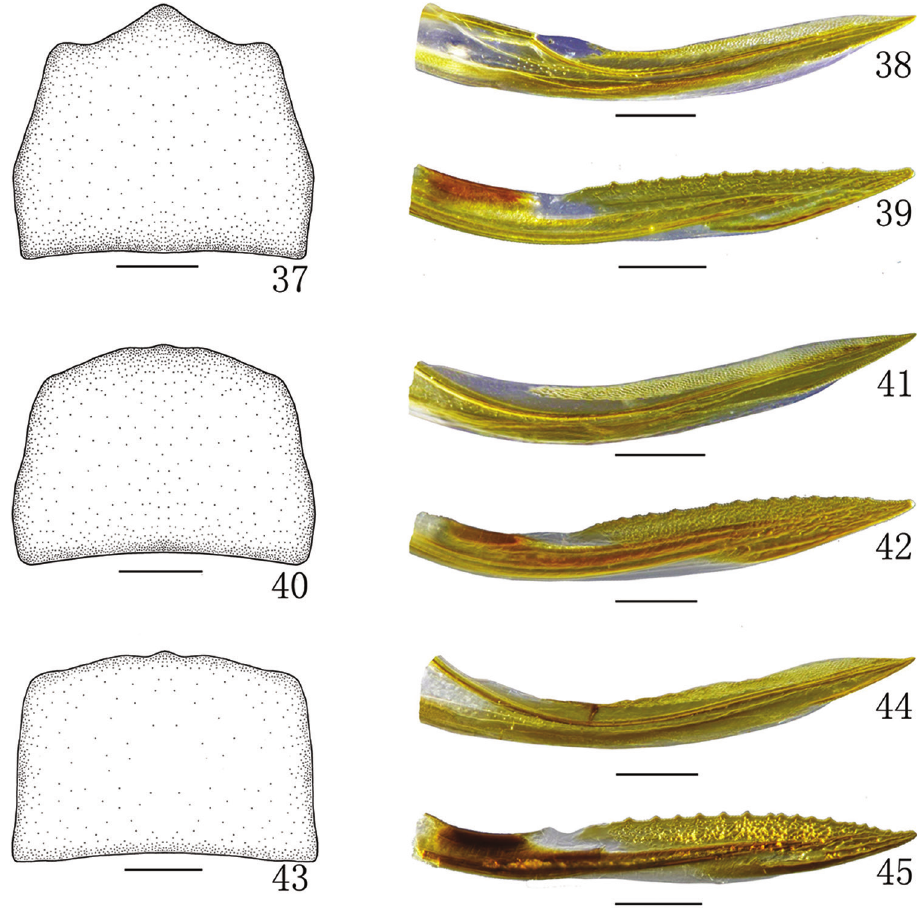
Species of Neomohunia are distinctly marked leafhoppers, mainly with orange, brown and reddish orange markings dorsally including a reddish medial longitudinal stripe on the head and pronotum. In the male genitalia they can be distinguished by the aedea- gus with pair of spinous processes arising from base. All are very similar in